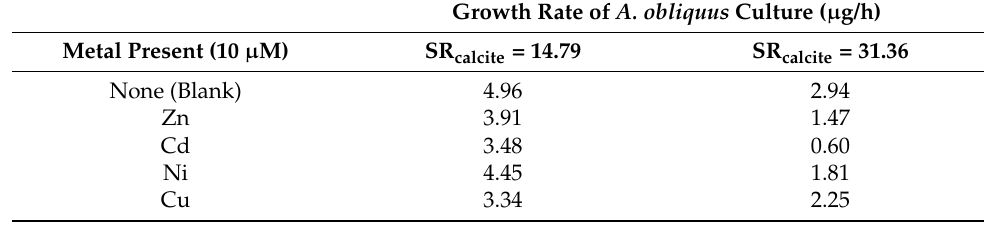
was the rate measured in the presence of Cu, while the highest rate corresponded to the